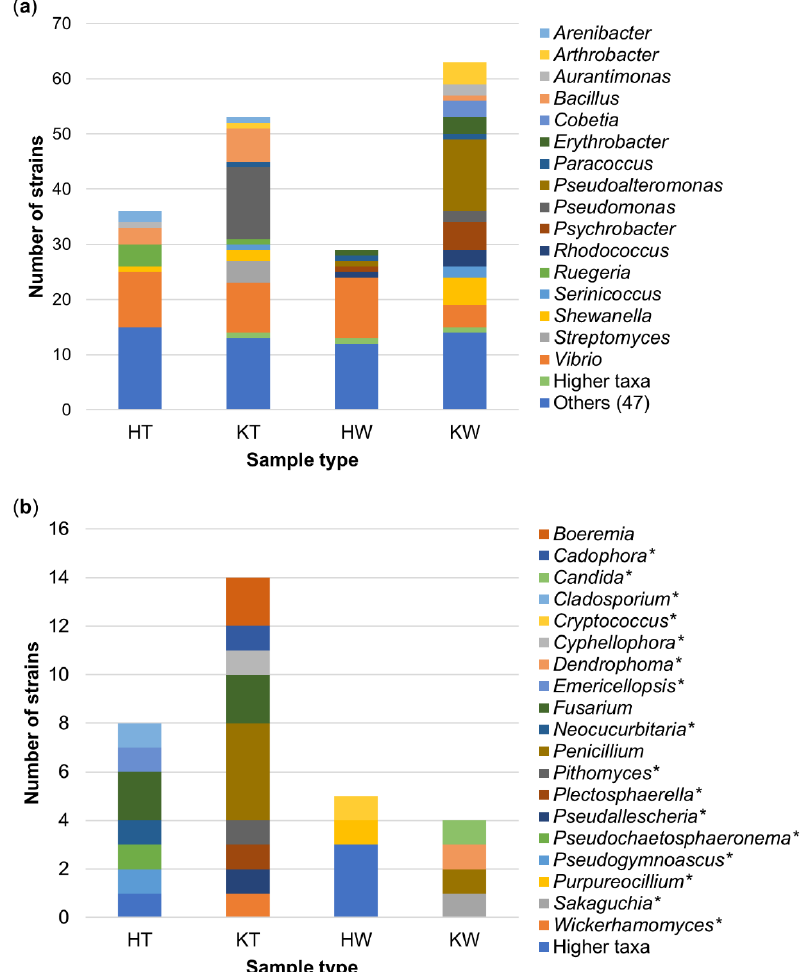
Figure 3. Taxonomic distribution of microorganism genera associated with the tunic of C. intestinalis